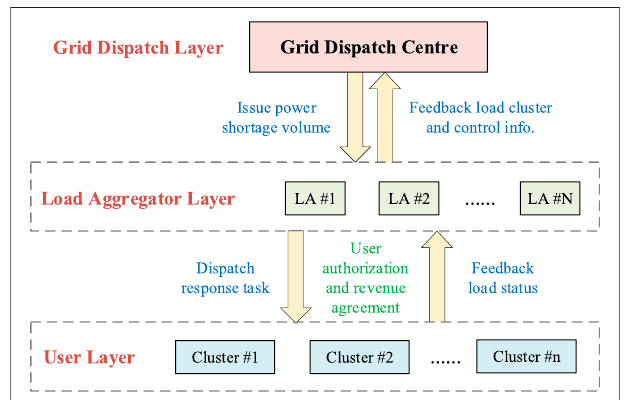
FIGURE 4 | The multilayer control structure of demand